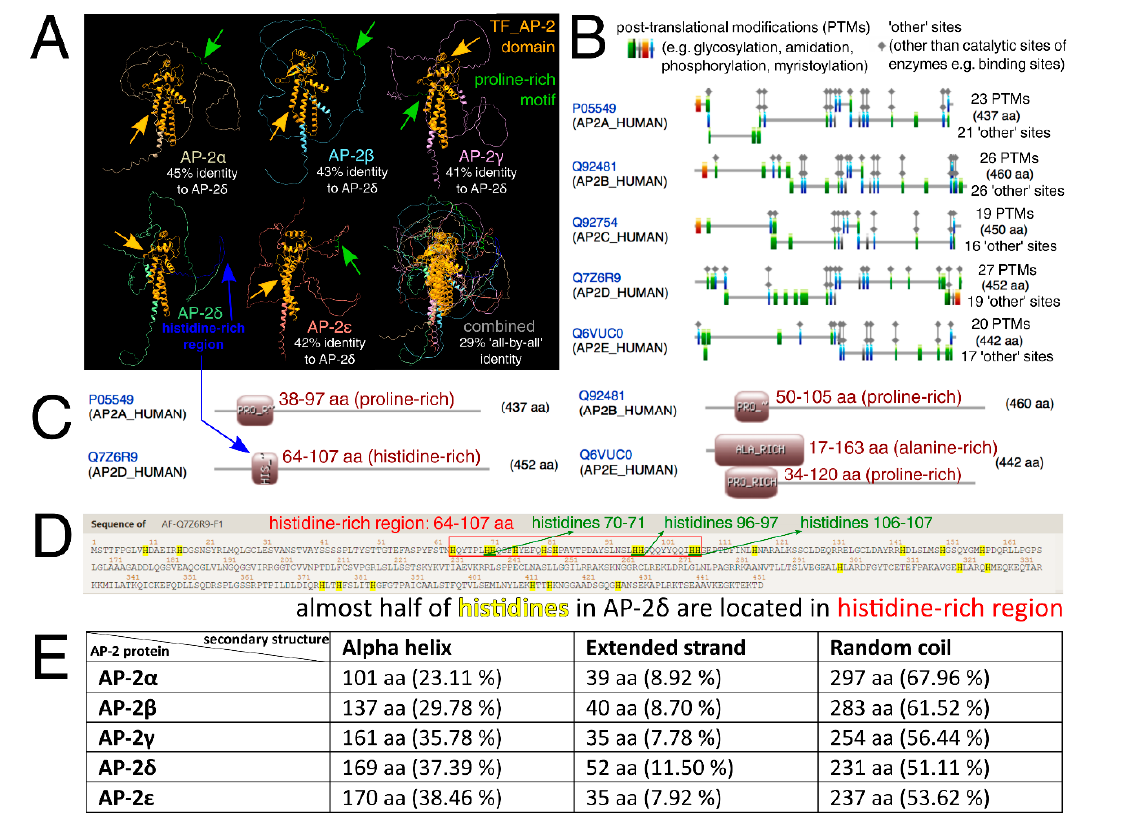
Figure 2. Similarities and differences of AP-2 factors with regard to protein structures, frequent patterns, and amino acid-rich regions. ( A ) Three-dimensional protein structures of AP-2 factors, with additional overlapping, were shown via ChimeraX, while the percentages of structure identity (in relation to AP-2 δ ) were estimated using Clustal Omega. “TF_AP-2” domains are marked in orange, proline-rich motifs (of AP-2 α / β / γ / ε ) are in green, while the histidine-rich region (of AP-2 δ ) is in blue. ( B ) ScanProsite tool revealed that the highest number of PTMs can be found in AP-2 δ . ( C ) Based on ProSite data, the histidine-rich region of AP-2 δ (shown beforehand in the first subfigure) overlaps with the proline-rich region found in other AP-2 proteins. ( D ) Visualization of AP-2 δ sequence with emphasis on histidines (highlighted in yellow) and histidine-rich region (framed in red). Two histidines in a row (“HH”) are underlined in green. ( E ) The GOR4 algorithm (estimating protein secondary structures) indicated that AP-2 δ contains the smallest number of random coils but the highest of extended strands. Provided are both the quantity and percentage of amino acids that form these structures.